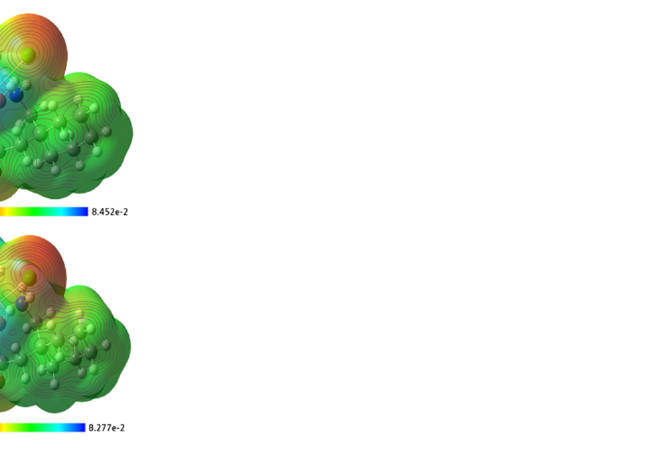
Figure 17. The MEP surface map of the synthesized metal complexes ( a ) [Mn(II)–(Gpn)], ( b ) [Co(II)– (Gpn)], ( c ) [Ni(II)–(Gpn)], and ( d ) [Cu(II)–(Gpn)] with the respective color scales.